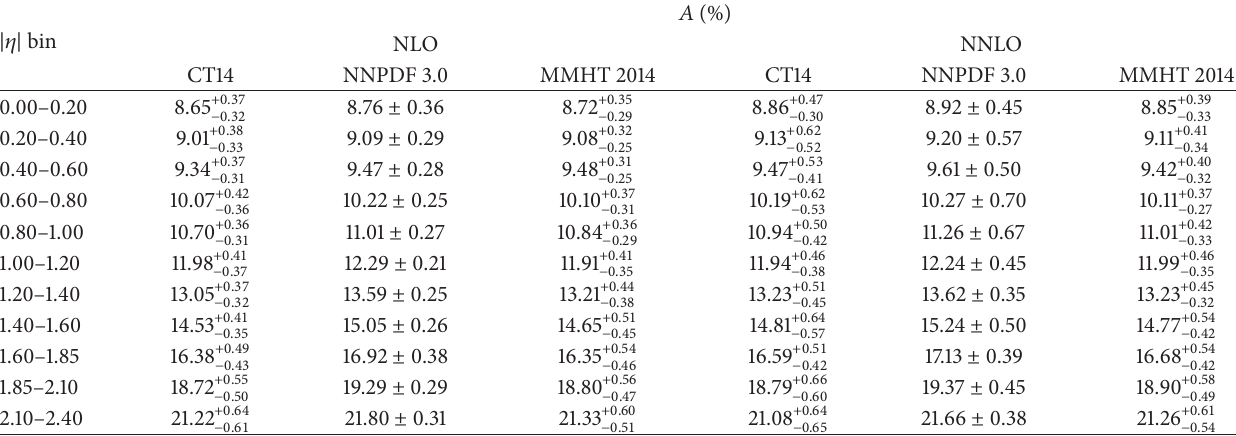
Table3:PredictedasymmetrynumbersforCT14,NNPDF3.0,andMMHT2014PDFswithNLOandNNLOQCDcorrectionsat √𝑠 = 13